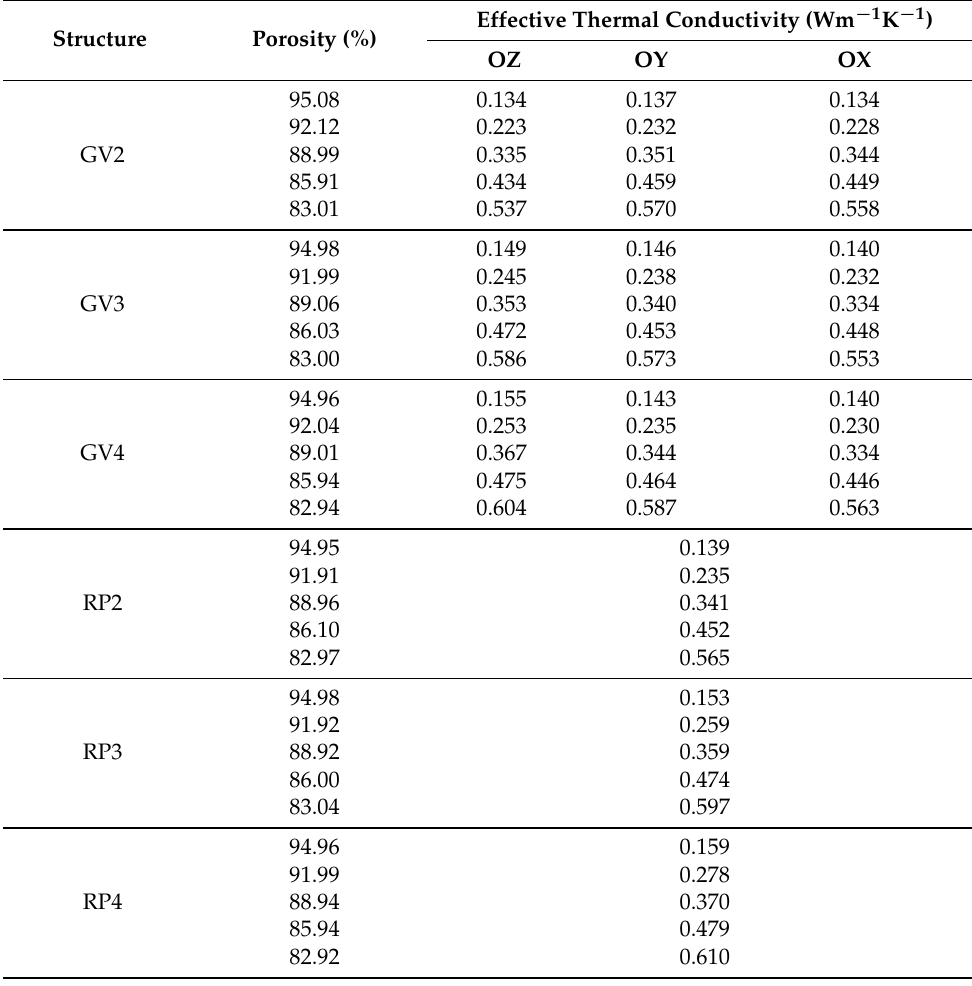
Table 5. Effective thermal conductivity of three-dimensional Voronoi gradient random porous materials with different porosity, gradient structure and